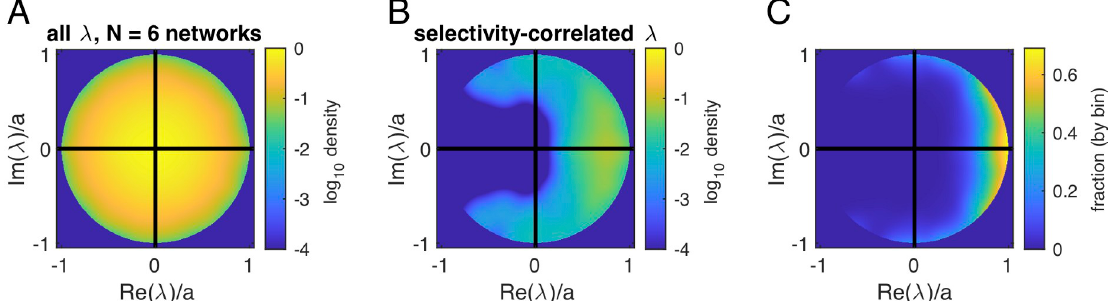
Fig 5. Eigenvalue spectrum of the linearized rate network. A. Density plot of all eigenvalues in the linearized network. B. Density plot of eigenvalues corresponding to eigenvectors with significant correlation to the pattern of selectivity across the network. C. The fraction of eigenvectors that are significantly correlated with selectivity pattern, computed as the ratio of density in (B) to that in (A). For A and B, the radius of the distribution varied across networks so to average across networks we normalized by the maximum absolute value of eigenvalues a within each network ( a = 0.168 ± 0.005). Density is smoothed with a Gaussian kernel of width σ = a /10 and zeroed outside the unit